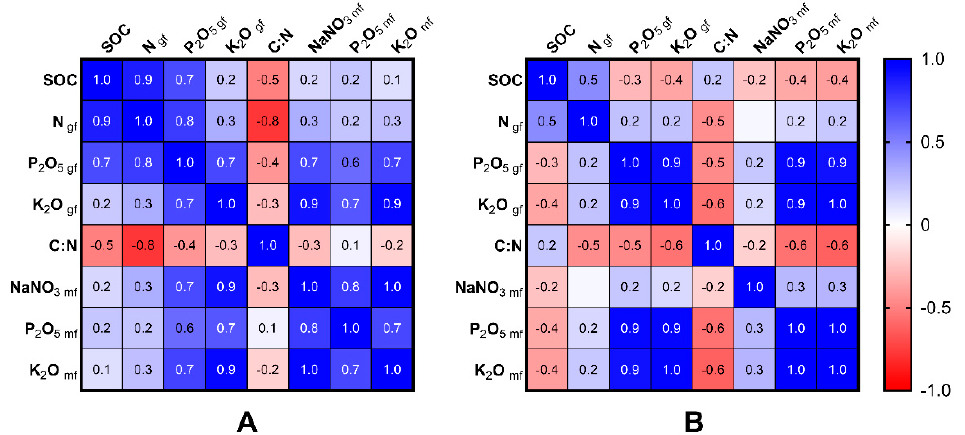
Figure 2. Spearman correlation matrix between agrochemical characteristics: ( A ) 0–32 cm depths ( n = 12); ( B ) 32–50 cm depths ( n = 12). Note: gf—gross form; mf—mobile form.